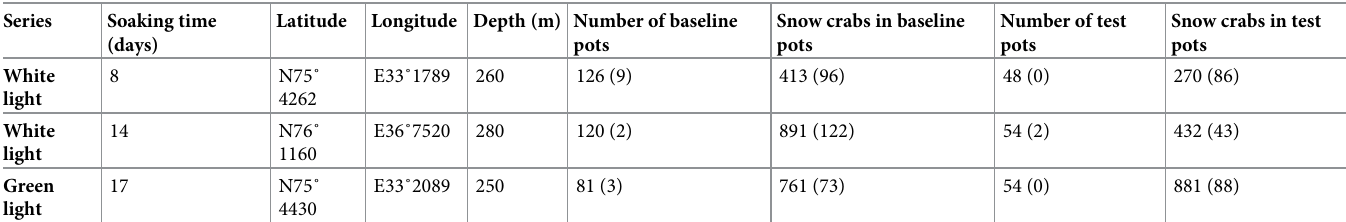
Corresponding start position of the lines, depth, soaking time, number of pots used for carapace width measurements in test and baseline pots, and number of snow crabs retained in test and baseline pots in each experiment. Number in parentheses for the snow crab shows the amount of snow crab under minimum landing size of 95 mm CW. Number in parentheses for the pots shows the number of empty pots.